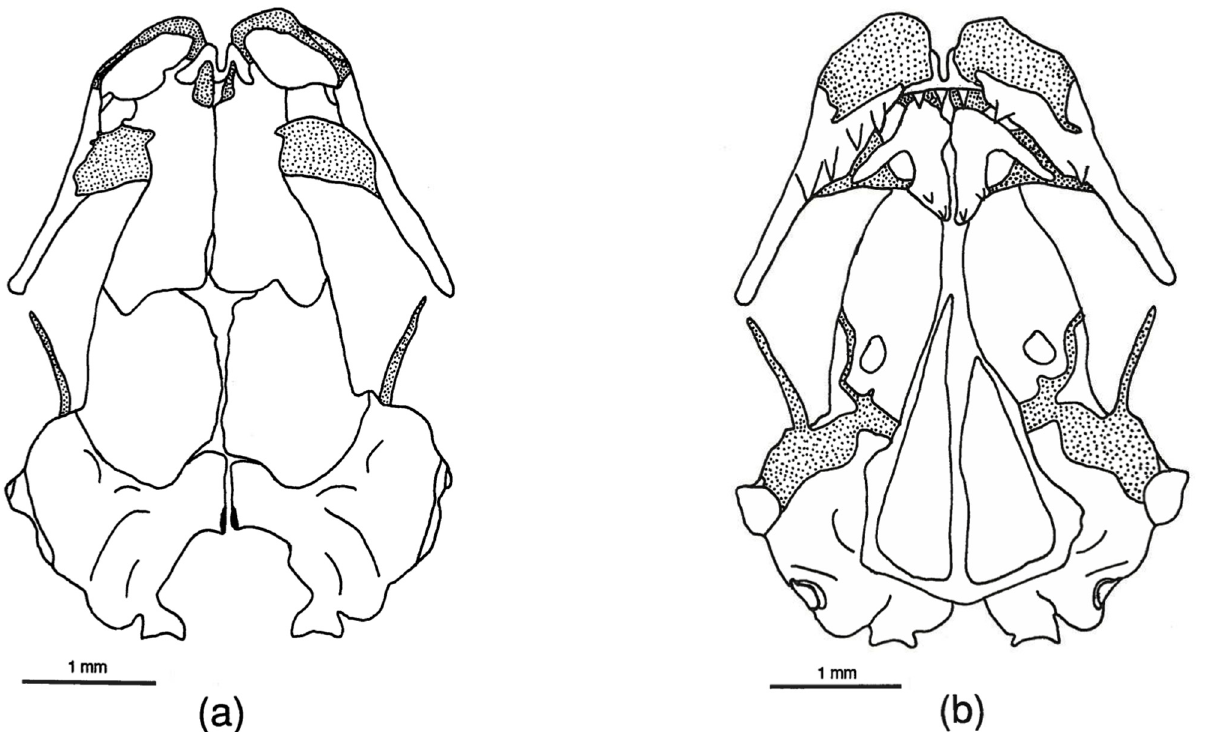
Fig 5. Chiropterotriton dimidiatus skull. Drawings of dorsal (a) and ventral (b) aspects of the skull of Chiropterotriton dimidiatus (MVZ 103967). Stippled areas represent cartilage. Elements as labeled in Fig 1.